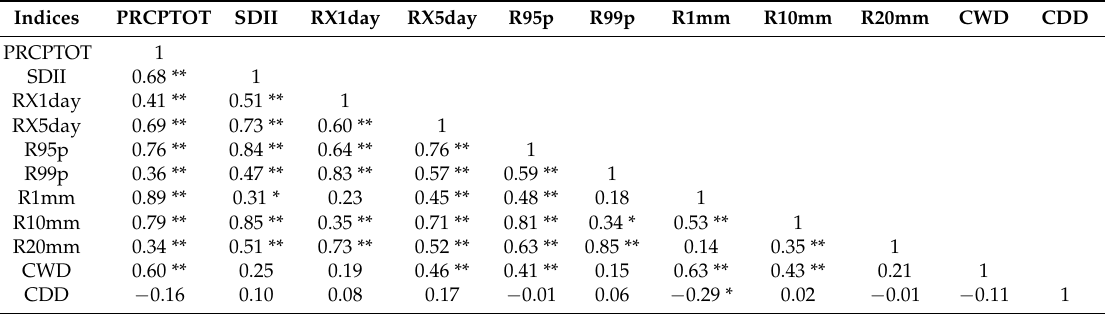
Table 7. Correlation coefficients of extreme precipitation indices.